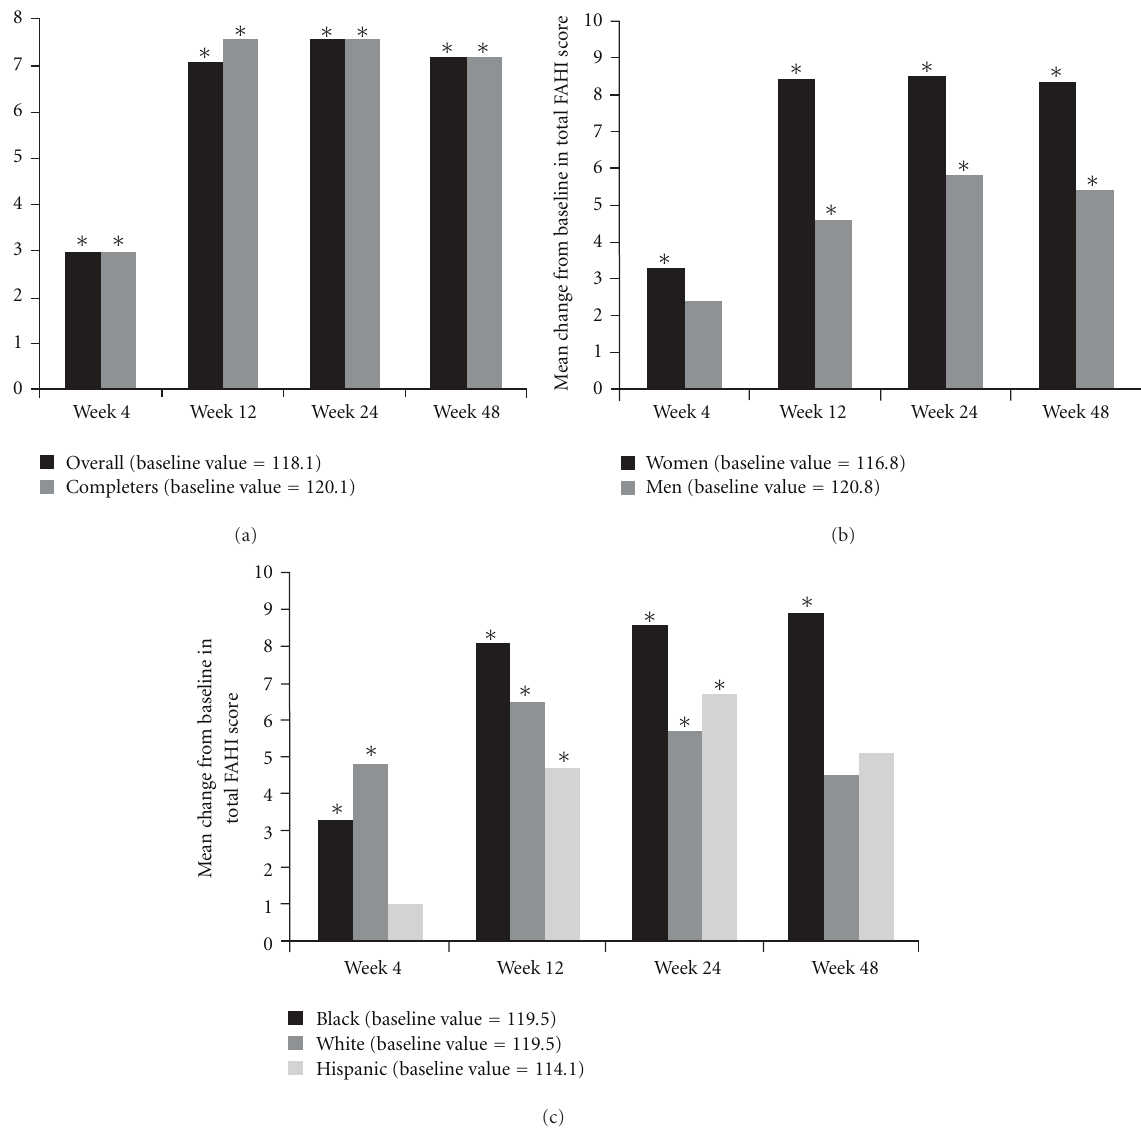
Figure 2: Mean change from baseline in total FAHI score in (a) the overall population and completers a , (b) by sex, and (c) by race b (observed). ∗ Statistically significant change from baseline ( P < . 05). a Excludes patients who discontinued the trial. b Four patients self- identified as Asian or other and were not included in the analysis by race due to small sample size; FAHI: functional assessment of HIV